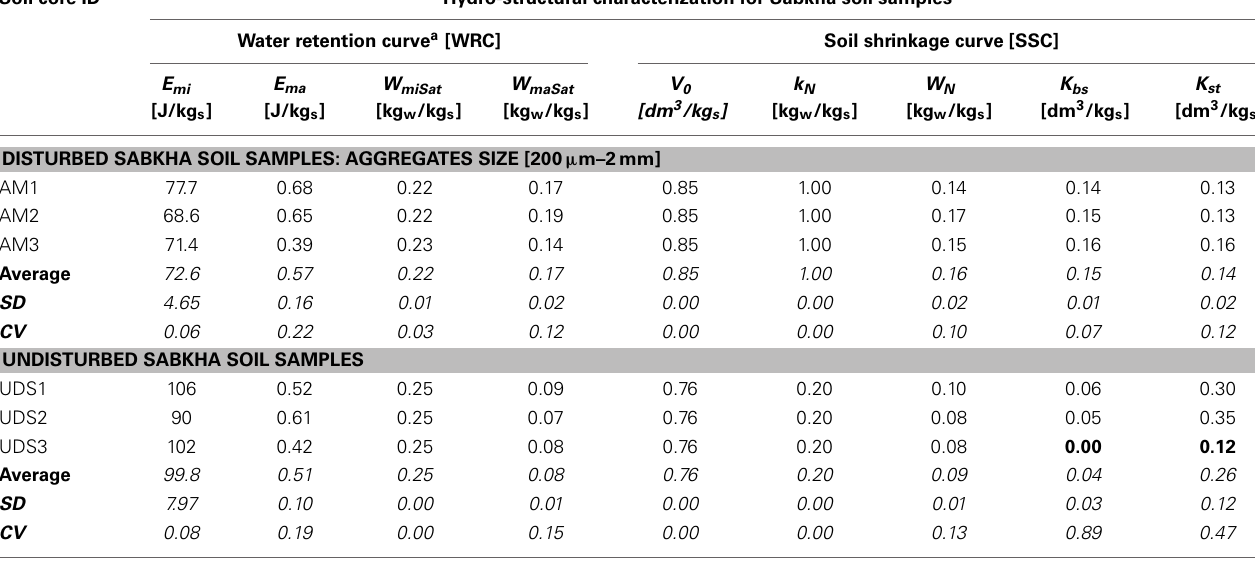
Table 4 | Hydro-structural parameters for the water retention curves and soil shrinkage curves of the reconstituted and undisturbed Sabkha soil